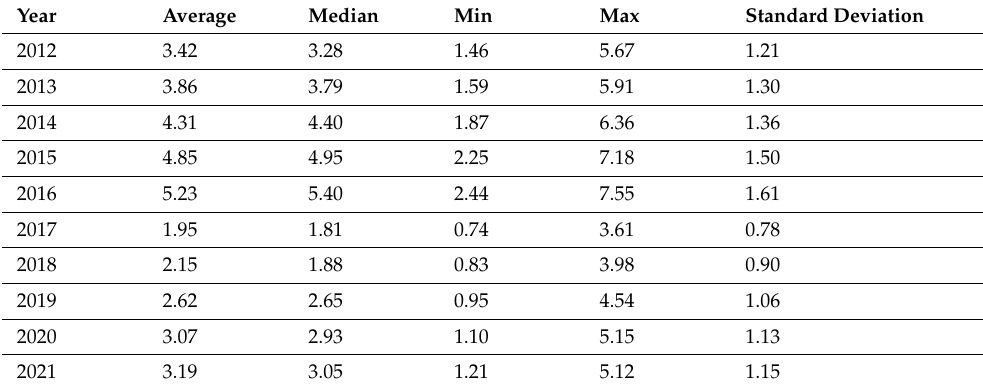
Table 6. Basic descriptive statistics for variability of bicycle road lengths per 10,000 inhabitants in following